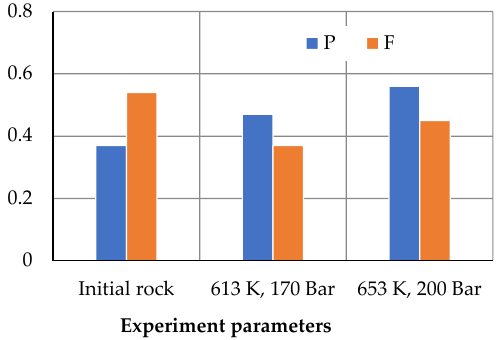
Figure 2. Thermal analysis of carbonate rock before and after experiments.